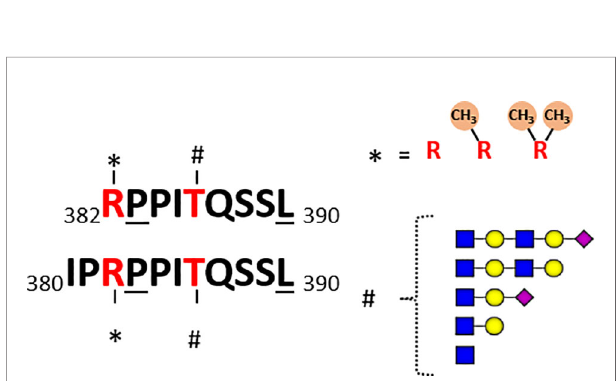
FIGURE 4 | Schematic of detected co-occurring peptidoforms for the two overlapping unique HLA peptides detected, RPPITQSSL and IPRPPITQSSL, originating from RNA-binding protein 27. In the datasets of both Marino et al. and Malaker et al. several O -GlcNAcylated HLA peptides originating from the RNA binding protein 27 were reported. In Marino et al. the backbone sequence covered aa 380-390, whereas Malaker et al. observed the alike peptide covering aa 382-390. These peptides are likely HLA-B*07:02 binders, due to the underlined anchoring positions Pro at 2 and Leu at C-terminal position. In both datasets peptides were found with the Arg at 1 (3) being non-methylated, mono-methylated or di-methylated. The Thr at P5 (P7) was detected in several different glycoforms: non-O-GlcNAc, one GlcNAc, hexose-GlcNAc and even more extended glycans with mass shifts of 730 and 1021